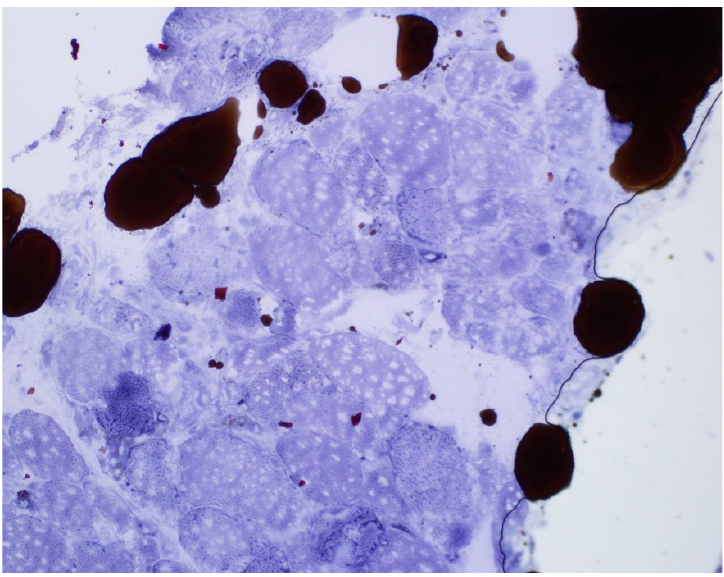
Figure 2. Immunohistochemistry (CD 68-macrophage) foci of infiltrate.